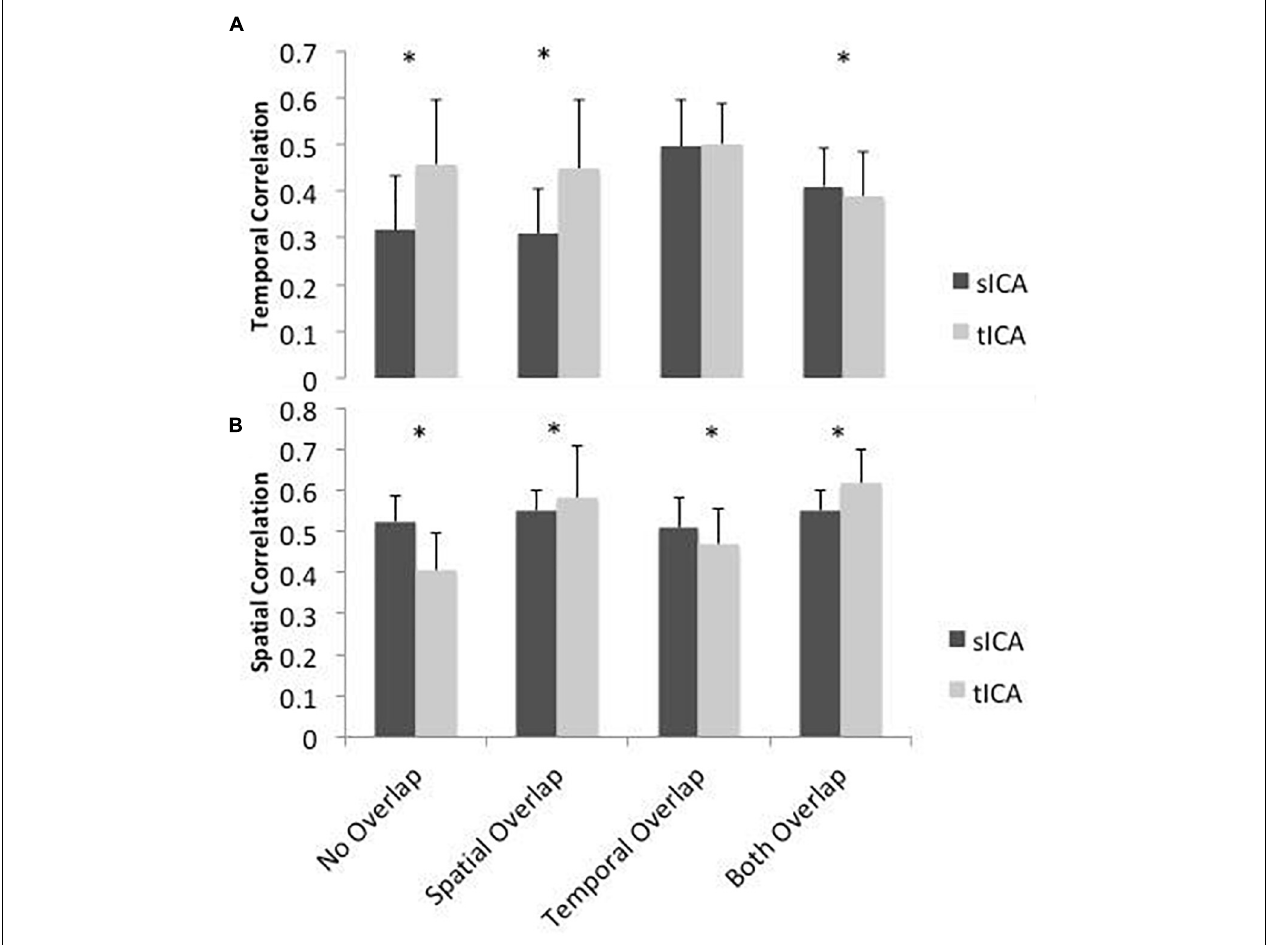
FIGURE 3 | Simulated performance of sICA (black) and tICA (gray) in identifying signal components and spatial patterns. Performance is measured by calculating the correlation between the temporal (A) and spatial patterns (B) of the ground-truth and estimated components. Thus, a higher correlation indicates superior performance. When the components are spatially correlated, tICA performs better, whereas when the components are temporally inter-correlated, sICA results are more favorable. When components are both temporally and spatially correlated (“Both Overlap”), sICA results in higher performance in terms of temporal correlation with the ground truth, while tICA results in higher performance in terms of spatial correlation with the ground truth. Error bars show standard deviation across 100 simulations. Significant differences are indicated by asterisks ( p <